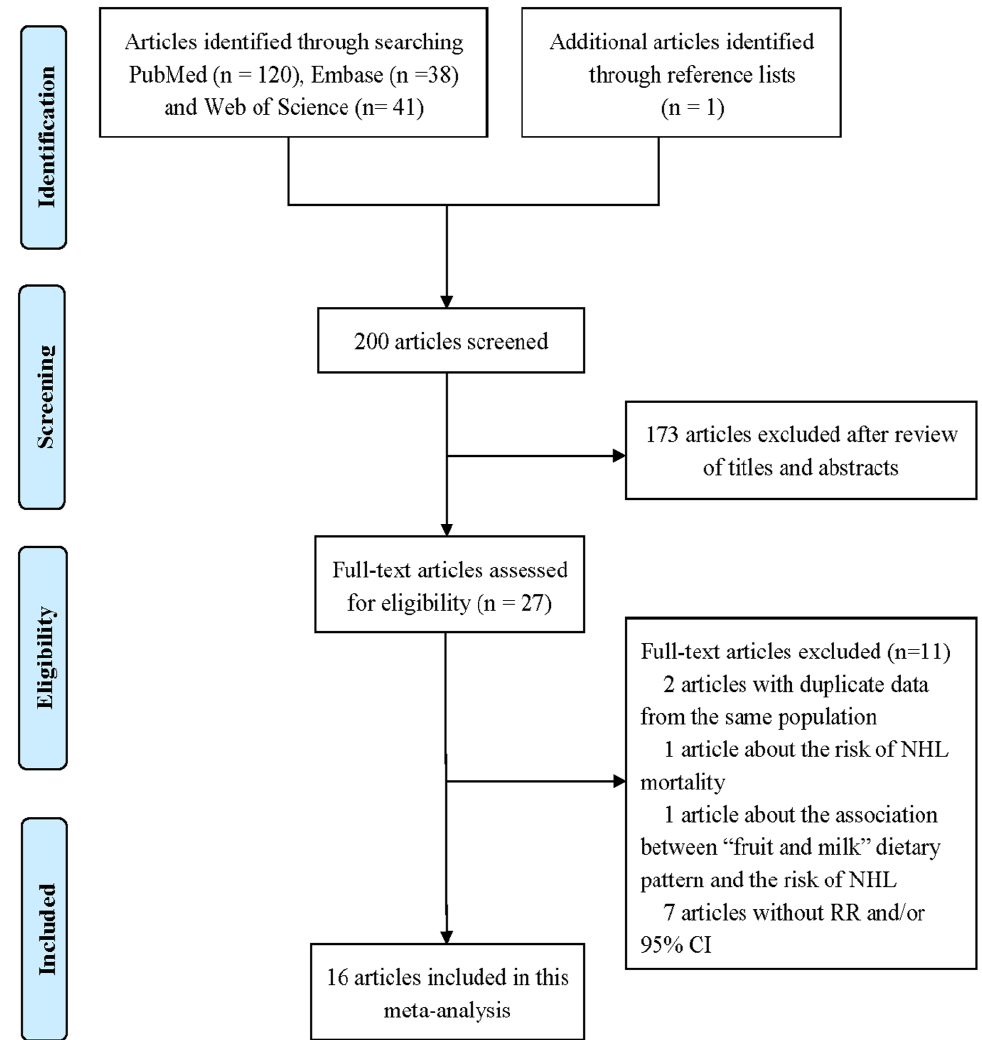
Figure 1. Flowchart of the selection of studies included in the meta ‐ analysis.